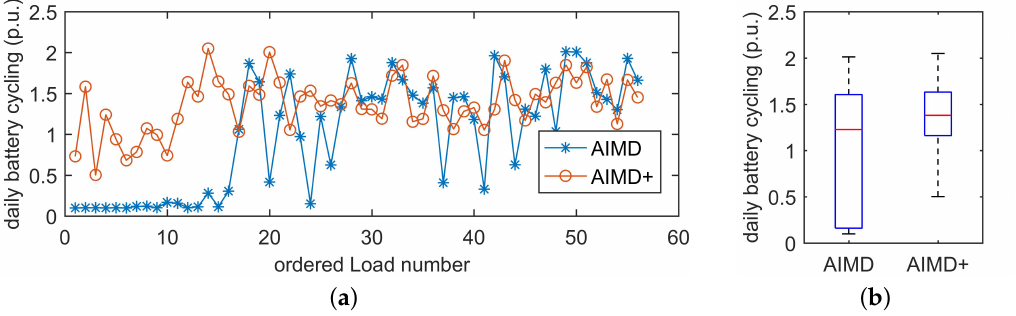
Figure 14. Each load’s battery cycling compared for ( a ) 60% EV and 100% AIMD and AIMD+ uptake and ( b ) in a statistical context. Here, ζ ∗∗∗ ( b )